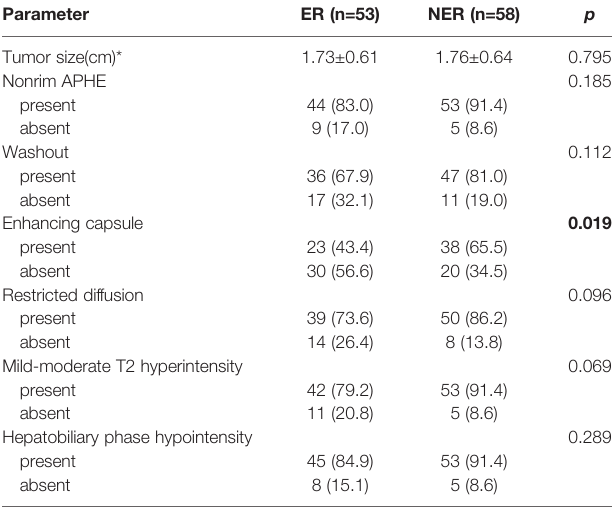
TABLE 2 | Analysis of radiologic features between ER and NER of small